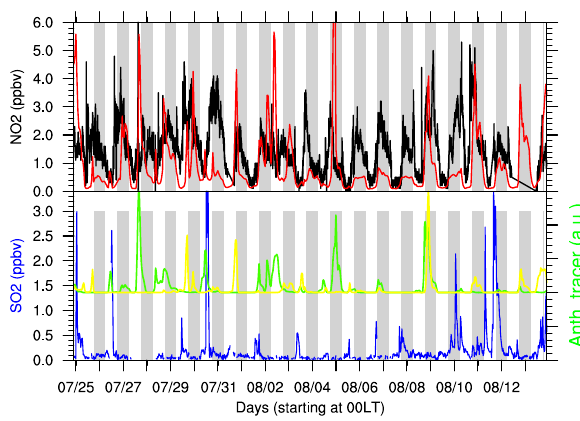
Fig. 4. Time series of NO 2 (black, Thermo 17i) and SO 2 (blue) sur- face concentrations as observed at the MFO site during the early stages of RoMBAS from 26 July to 14 August 2011. The WRF- Chem-predicted NO 2 is also shown (red, ppbv), as well as the lev- els of advected anthropogenic tracers (arbitrary units) from Den- ver (green) and Colorado Springs (yellow). Grey shadings indicate nighttime periods (8p . m . –8a . m . ).